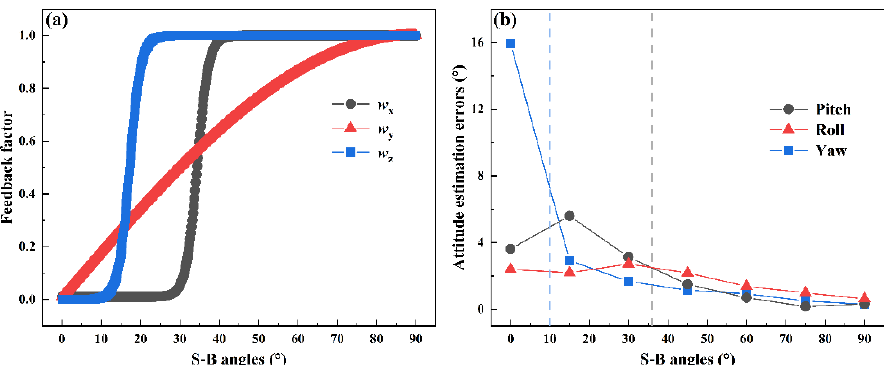
Figure 6. Three attitude feedback factors ( a ) and estimation errors ( b ) against different S-B angles. The blue and gray dash lines in (b) show the transition points of the yaw and pitch estimation error curves against S-B angles, respectively. It can be seen in Figure 6b that the steep fall of the yaw estimation error of the all-feedback method occurs at γ z = 15 ◦ . To further analyze the relationship between the improvement degree and γ z in the range around γ z = 15 ◦ , a smaller step in the γ z range from 2 ◦ to 20 ◦ is selected for the simulation condition as shown in Figure 7. The error drops at γ z = 4 ◦ , trends to easing from γ z = 8 ◦ , and becomes smaller than SINS error (4.48 ◦ ) from γ z = 10 ◦ (3.30 ◦ ), and tend to decrease slowly. Thus, when γ z is larger than 10 ◦ , POL can provide effective correction for INS. Around this point, 0.3 is selected by trial-and-error simulation experiments. Therefore, the attitude angular adaptive partial feedback model is established to connect the S-B angles and state correction. When the three S-B angles are large enough, 11 of 18 the partial feedback factor matrix w approaches a 3 × 3 identity matrix I , and the AFP is reduced to the conventional all-feedback method.